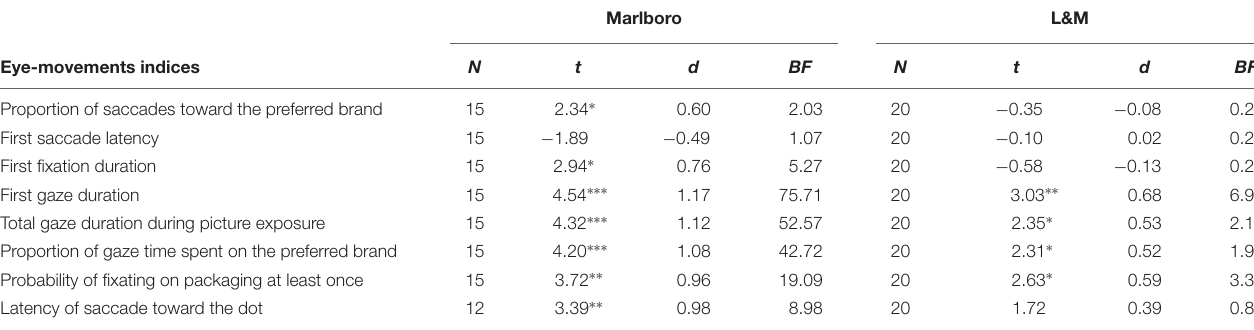
TABLE 2 | Eye movement biases toward “own” vs. “other” brands for participants declaring Marlboro or L&M as the most commonly used